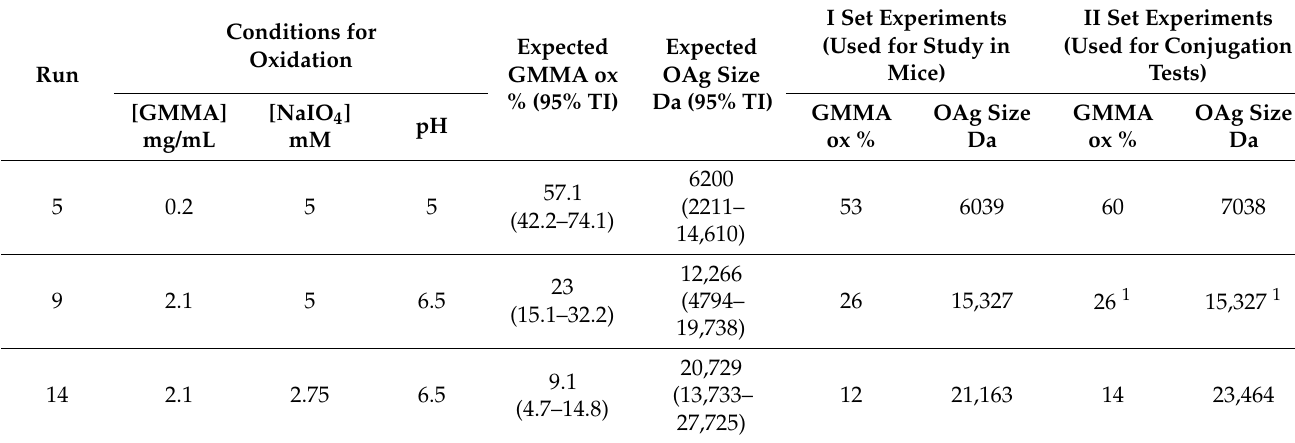
Table 1. Three different conditions selected for producing GMMA characterized by different GMMA ox % and OAg chain length, with expected results confirmed by experimental ones.